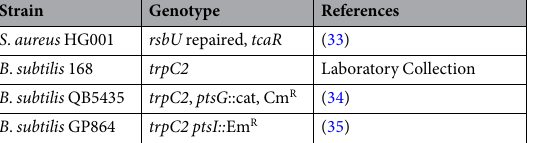
Table 2. Laboratory strains used for growth in the presence of FDG. Cm R , Chloramphenicol resistant; Em R , Erythromycin